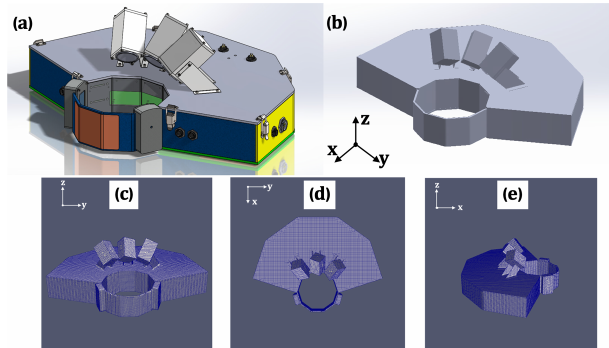
Figure 11. (a) Original MASC model as a stereolithography (STL) file; (b) MASC model neglecting small-scale details (e.g., bolts, holes, patches); (c–e) snapped mesh on MASC in three viewing di-